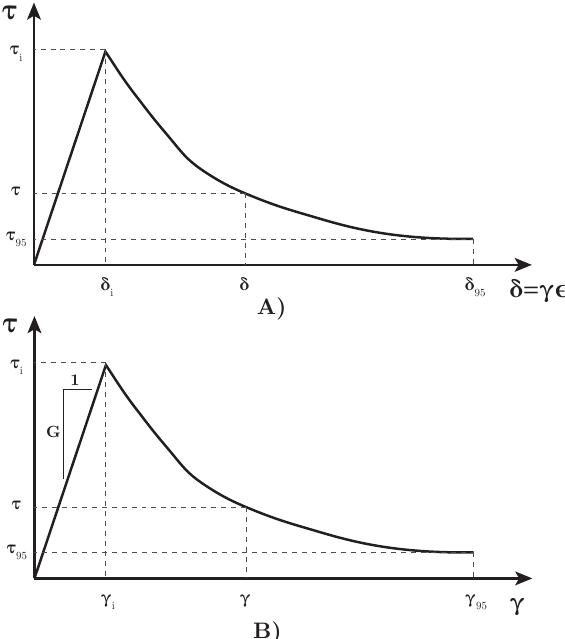
Figure 3. Degradation curve in terms of the displacement ( A ) and the shear strain ( B ).